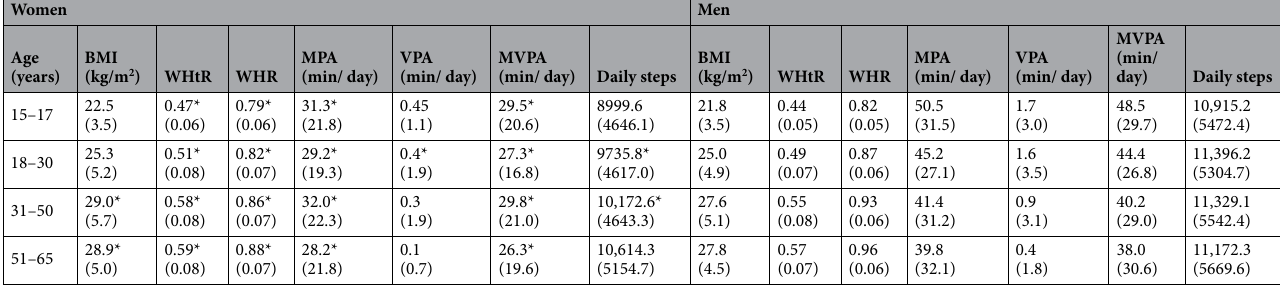
Table 2. Comparison (mean [95%CI] and SD) of overweight/obesity indicators and physical activity in relation to sex and age category. BMI, body mass index; WHtR, waist-to-height ratio; WHR, waist-hip ratio; MVPA, moderate-vigorous physical activity. *Difference between men and women made with the t-Student